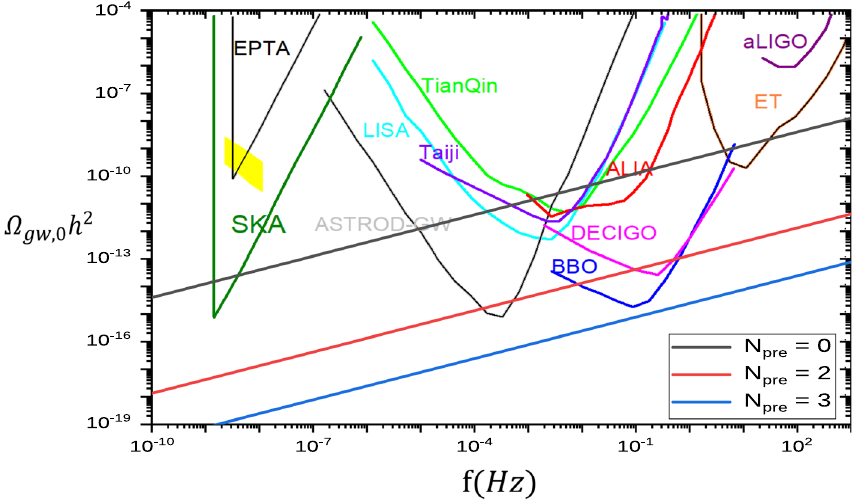
Fig. 6 The abundance of gravity wave energy density as function of the present value of the frequency. We display, from [89–94], the sensitivity curves of the Square Kilometer Array (SKA), European Pulsar Timing Array (EPTA), Astrodynamical Space Test of Relativ- ity using Optical-GW detector (ASTROD-GW), Laser Interferome- ter Space Antenna (LISA), Advanced Laser Interferometer Antenna